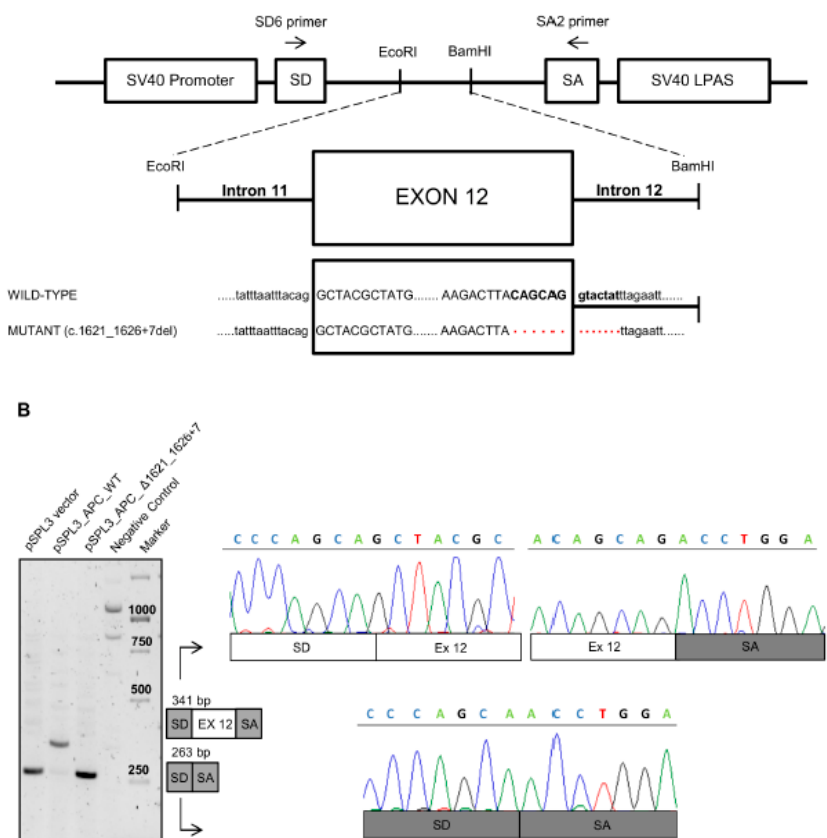
Figure 3. Splicing minigene reporter assay based on the pSPL3 exon-trapping vector. ( A ) Schematic representation of the pSPL3 minigene reporter used for the molecular characterization of APC splicing mutation c.1621_1626+7del. The pSPL3 vector contains two exons (SD and SA) and a functional intron, with transcription beginning after the SV40 promoter and ending at the late poly(A) signal (LPAS). EcoRI and BamHI indicate the cloning sites used to subclone the genomic APC fragments obtained from the wild type and mutant alleles (c.1621_1626+7del). ( B ) RT-PCR analysis of transcripts derived from the indicated pSPL3 reporter minigenes transfected in HEK-293 cells. Left: Agarose gel electrophoresis showing the RT-PCR products obtained with the SD6 and SA2 primers from HEK-293 cells transfected with the pSPL3 empty vector (263 bp), the pSPL3 vector with the genomic APC fragment from the wild type allele (341 bp), or the pSPL3 vector with the genomic APC fragment from the mutant allele (263 bp), and untransfected HEK-293 cells (negative control). Center: Schematic diagrams showing the RT-PCR products obtained. Right: Sequencing electropherograms of the RT-PCR products